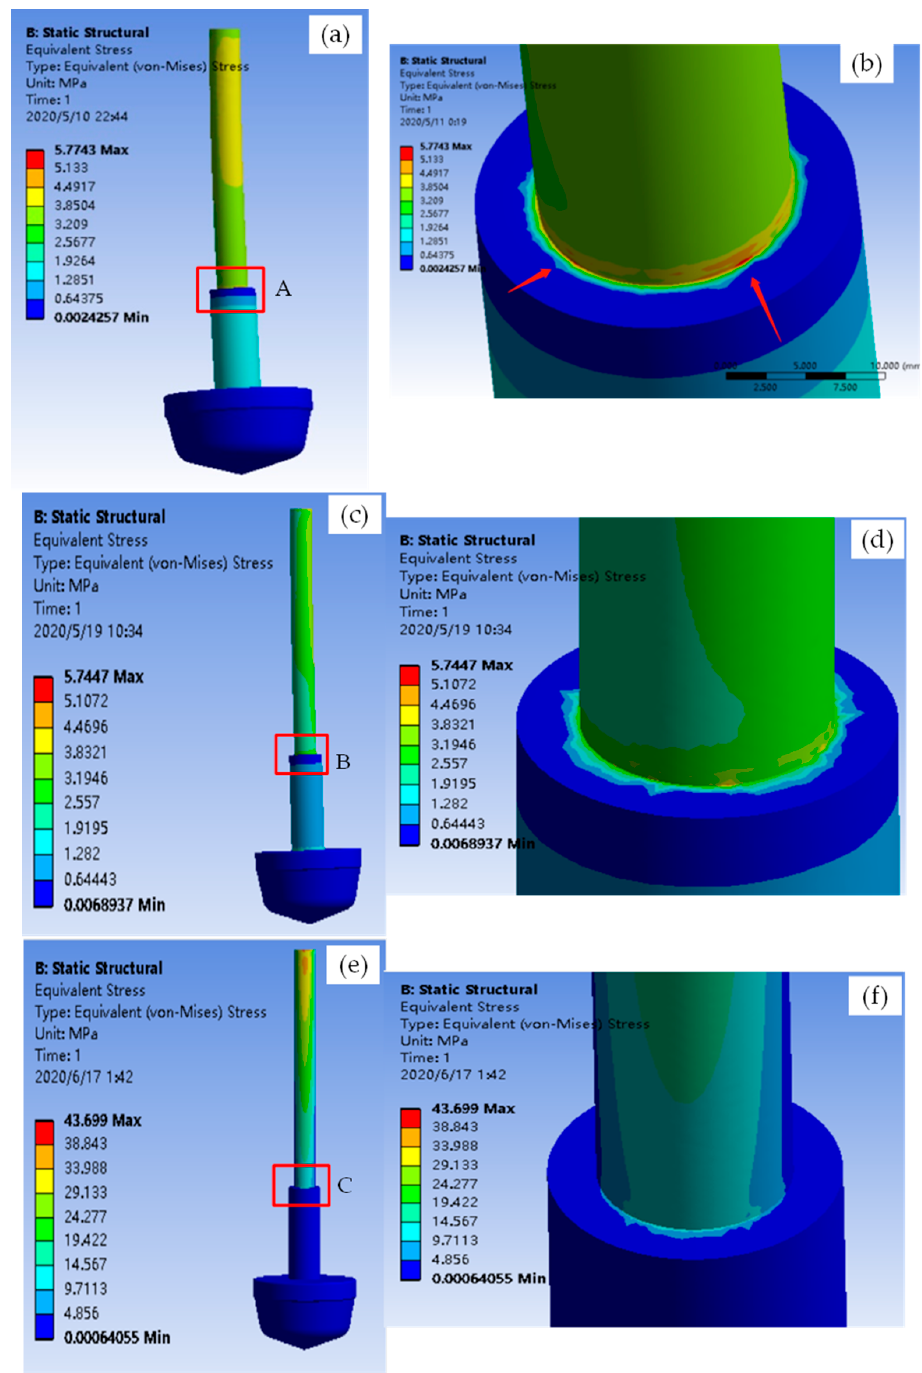
Figure 11. The total deformation diagram and equivalent stress diagram of the valve core and stem; ( a ) Equivalent stress diagram at 2% opening; ( b ) Enlarged view of Zone A; ( c ) Equivalent stress diagram at 15% opening; ( d ) Enlarged view of Zone B; ( e ) Equivalent stress diagram at 60% opening; ( f ) Enlarged view of Zone C.